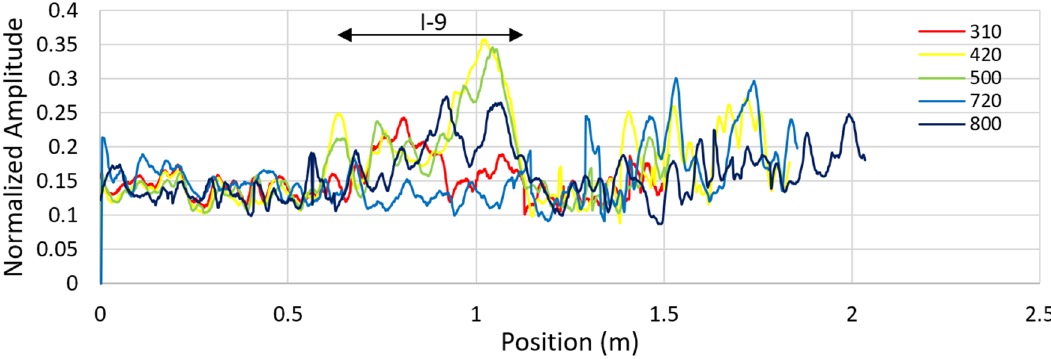
Figure 35. 2.6 GHz Normalized RW amplitudes on defect I-8, in the transversal direction vs. K loadings.